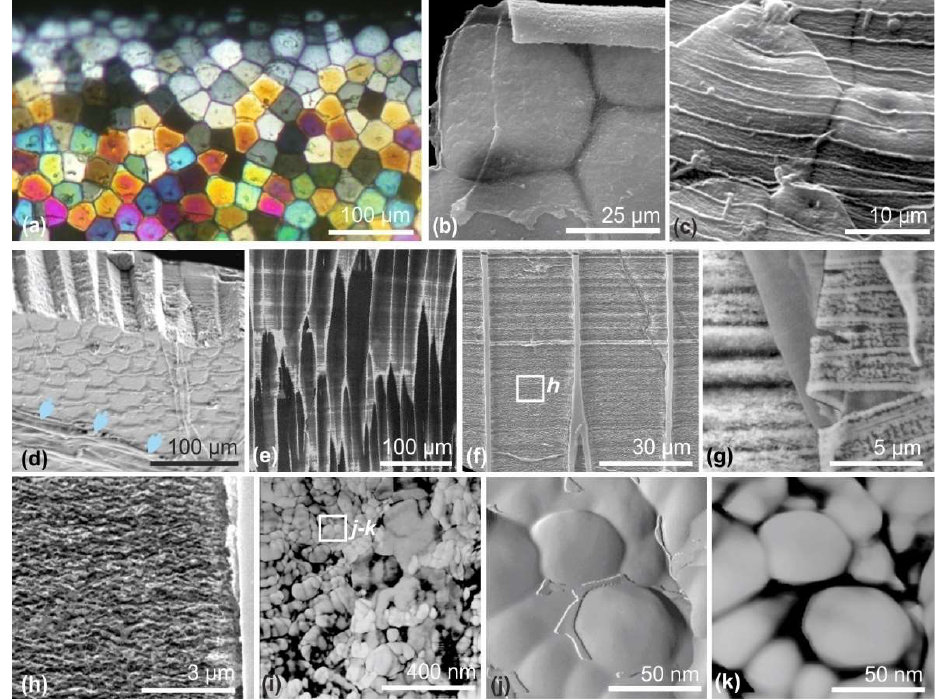
Figure 6. Layered growth of the prisms and morphology of the elementary mineralized units of Pinctada . ( a ) Transmitted polarized light on a large area of the shell growing edge. Thickness increase is assessed by the changing colors from the upper to lower part of the picture. Note the statistical dimensional regularity of the prism sections. ( b , c ) Inner ( b ) and outer ( c ) sides of the prisms at the shell growing edge. Note on the outer side the parallel stripes of the periostracum, indicating the pulsed secretion of the specialized cells in the deeper part of the outer grove of the mantle. ( d ) Internal surface of the shell prismatic layer; displaced Marsh membrane (blue arrows). ( e ) Slightly oblique surface in the prismatic layer showing the synchronic growth of the envelopes (laser confocal microscopy). ( f ) Layered growth mode of the mineralized phase. ( g ) Simultaneous growth of envelopes and mineral layers. ( h ) Discontinuous structure of the mineral material (SEM view). ( i – k ) AFM views of the mineralized material. ( j ) Amplitude image. ( k ) Phase contrast imaging. Credit pictures: (b,c,j,k) [21].